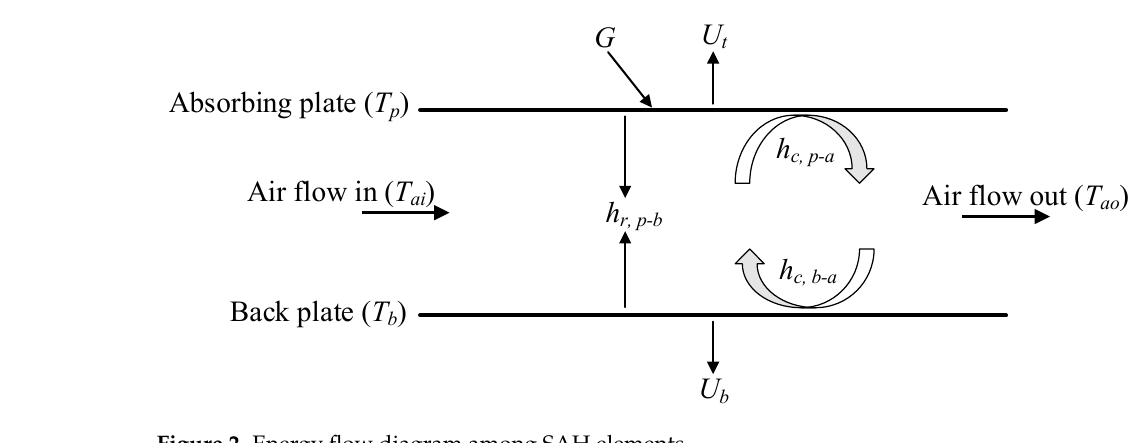
Figure 2. Energy flow diagram among SAH elements.